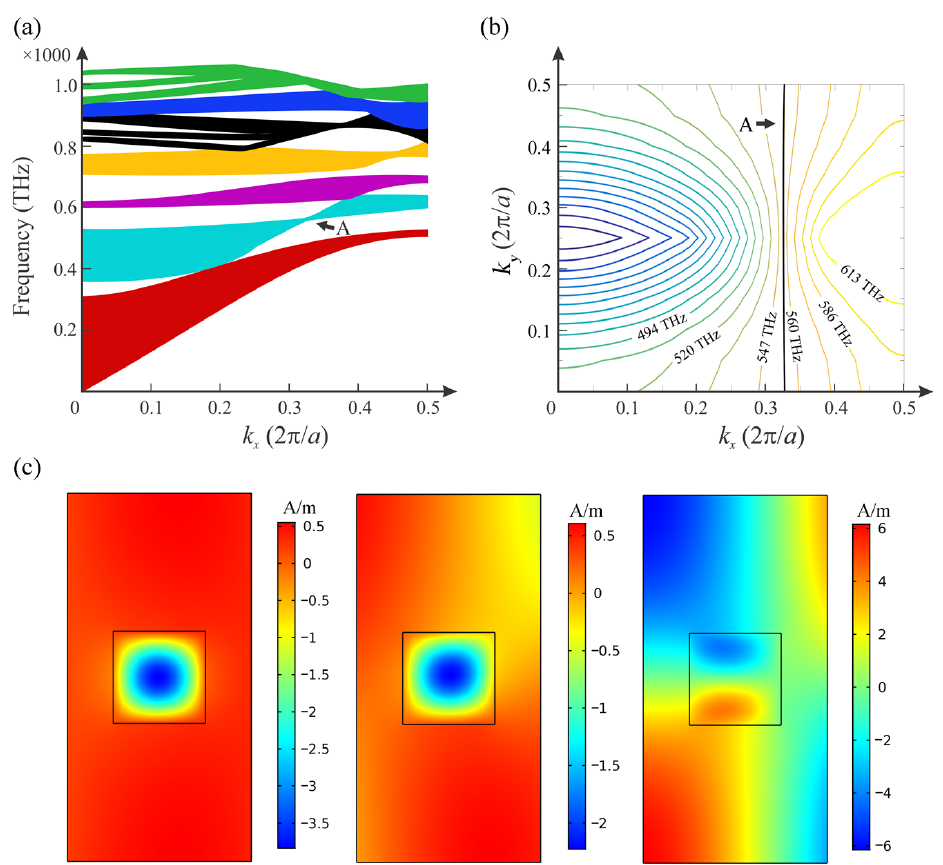
Figure 3. ( a ) Band structure of the HMM PhC membranes with filling factor of f = 0.2. Point A indi- cates an all-angle SC mode, ( b ) equifrequency contours of the second HMM PhC band, ( c ) magnetic field (| H |) profiles of point A with k y = 0, k y = 0.15 (2 π / a ) and k y = 0.25 (2 π / a ) in ( a ).